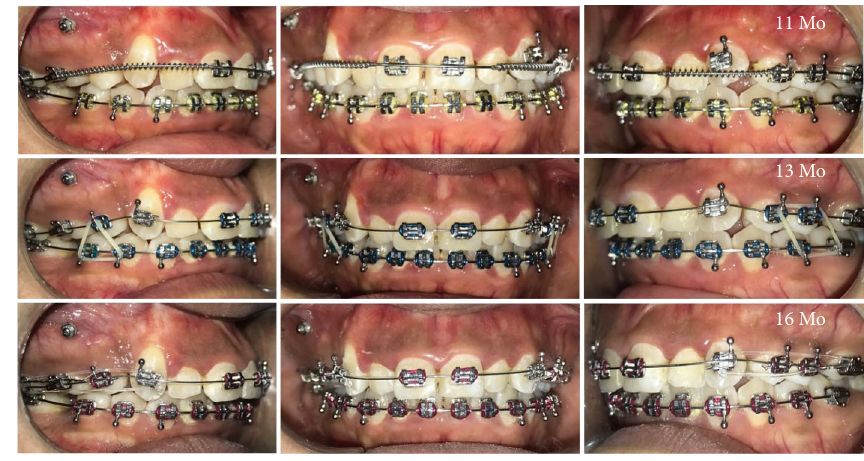
Figure 5: Light forces being used after spontaneous relapse of #13 into the bone in order to achieve intercuspation.